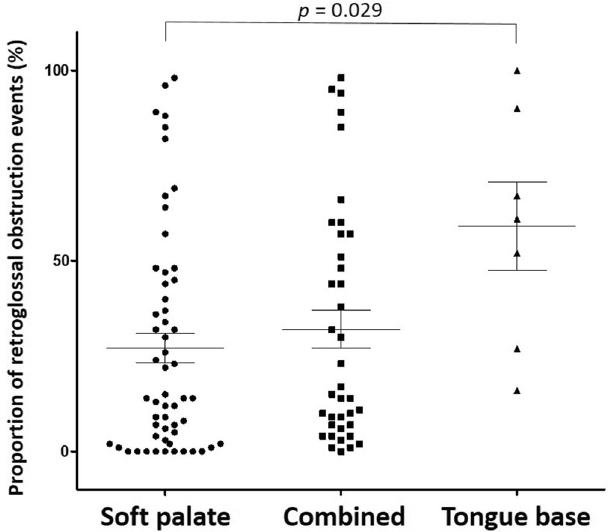
Figure 1. Proportion of retroglossal obstruction according to the obstructive pattern evaluated by DISF. Soft palate (27.2 ± 29.1), combined (32.1 ± 31.1), and tongue-based (59.0 ± 30.6) obstruction patterns.